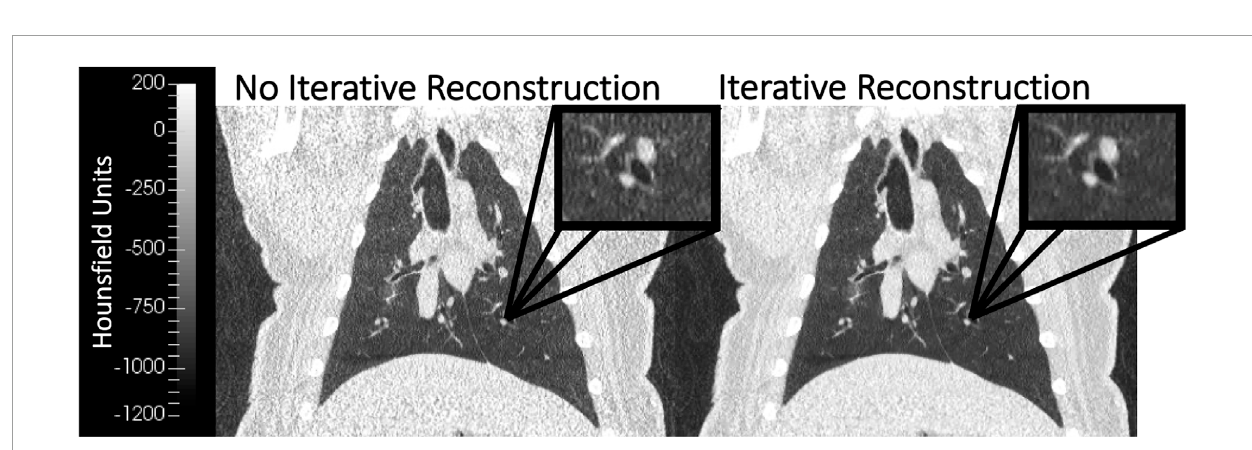
FIGURE 3 Coronal WMS images reconstructed without (left) and with (right) iterative reconstruction (IR) are shown. The image with IR applied demonstrates noise reduction when compared to the image without IR. Both images were acquired with the same image acquisition technique (10 mAs 4DCT).